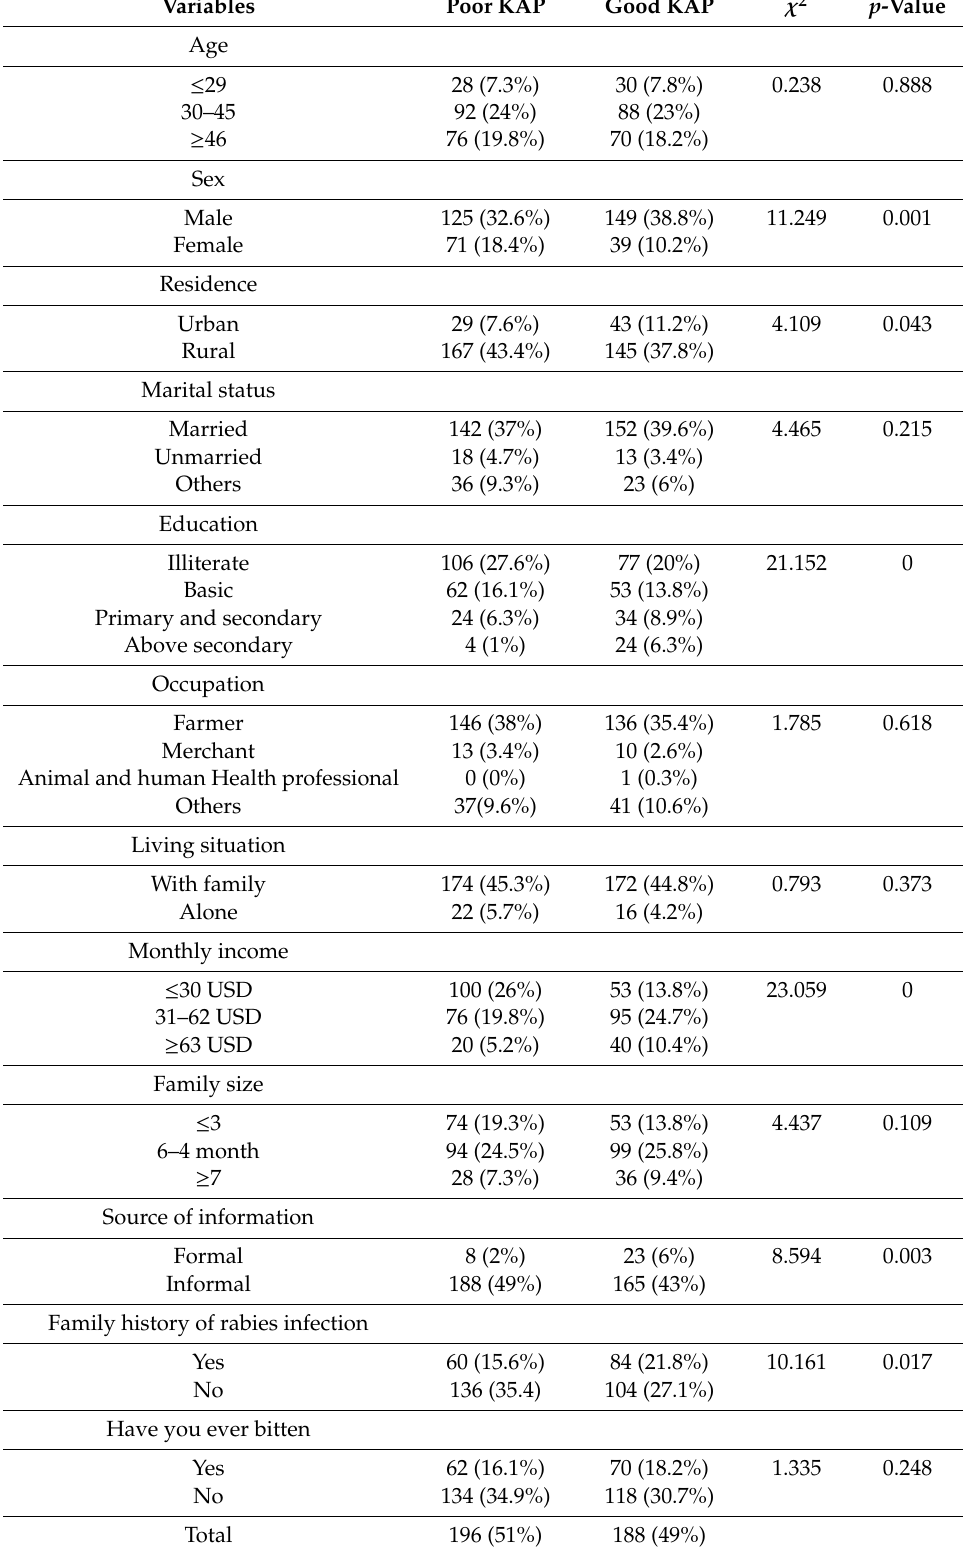
Table 7. Factors associated with Knowledge, Attitudes and Practices (KAP) of participants towards rabies (N = 384),